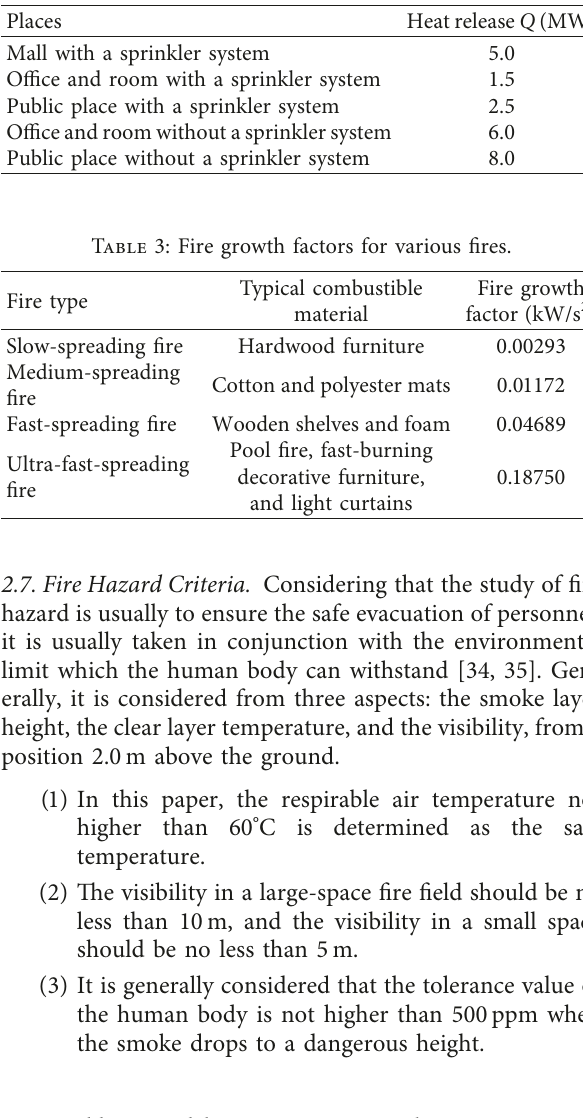
Table 2: Heat release for various sprinkler systems.